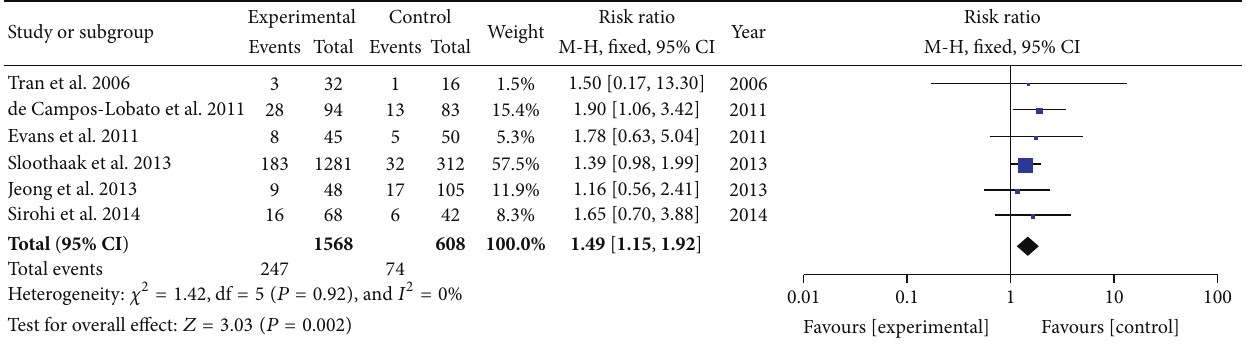
Figure 4: Standard forest plot of the RR for pCR rates comparing longer time intervals with shorter intervals at 8 weeks.